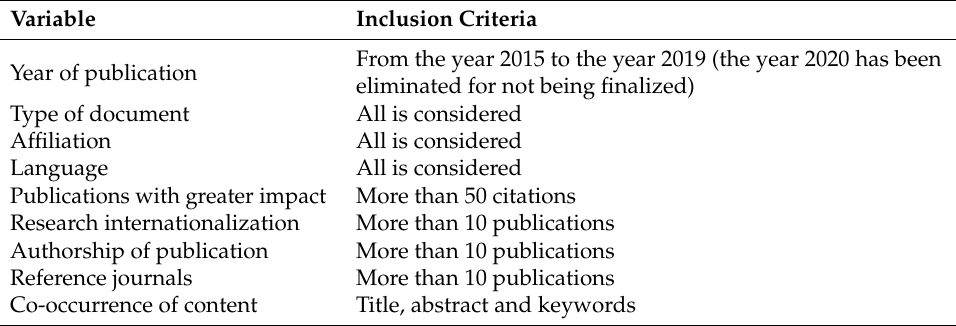
Table 1. Variables and inclusion/exclusion